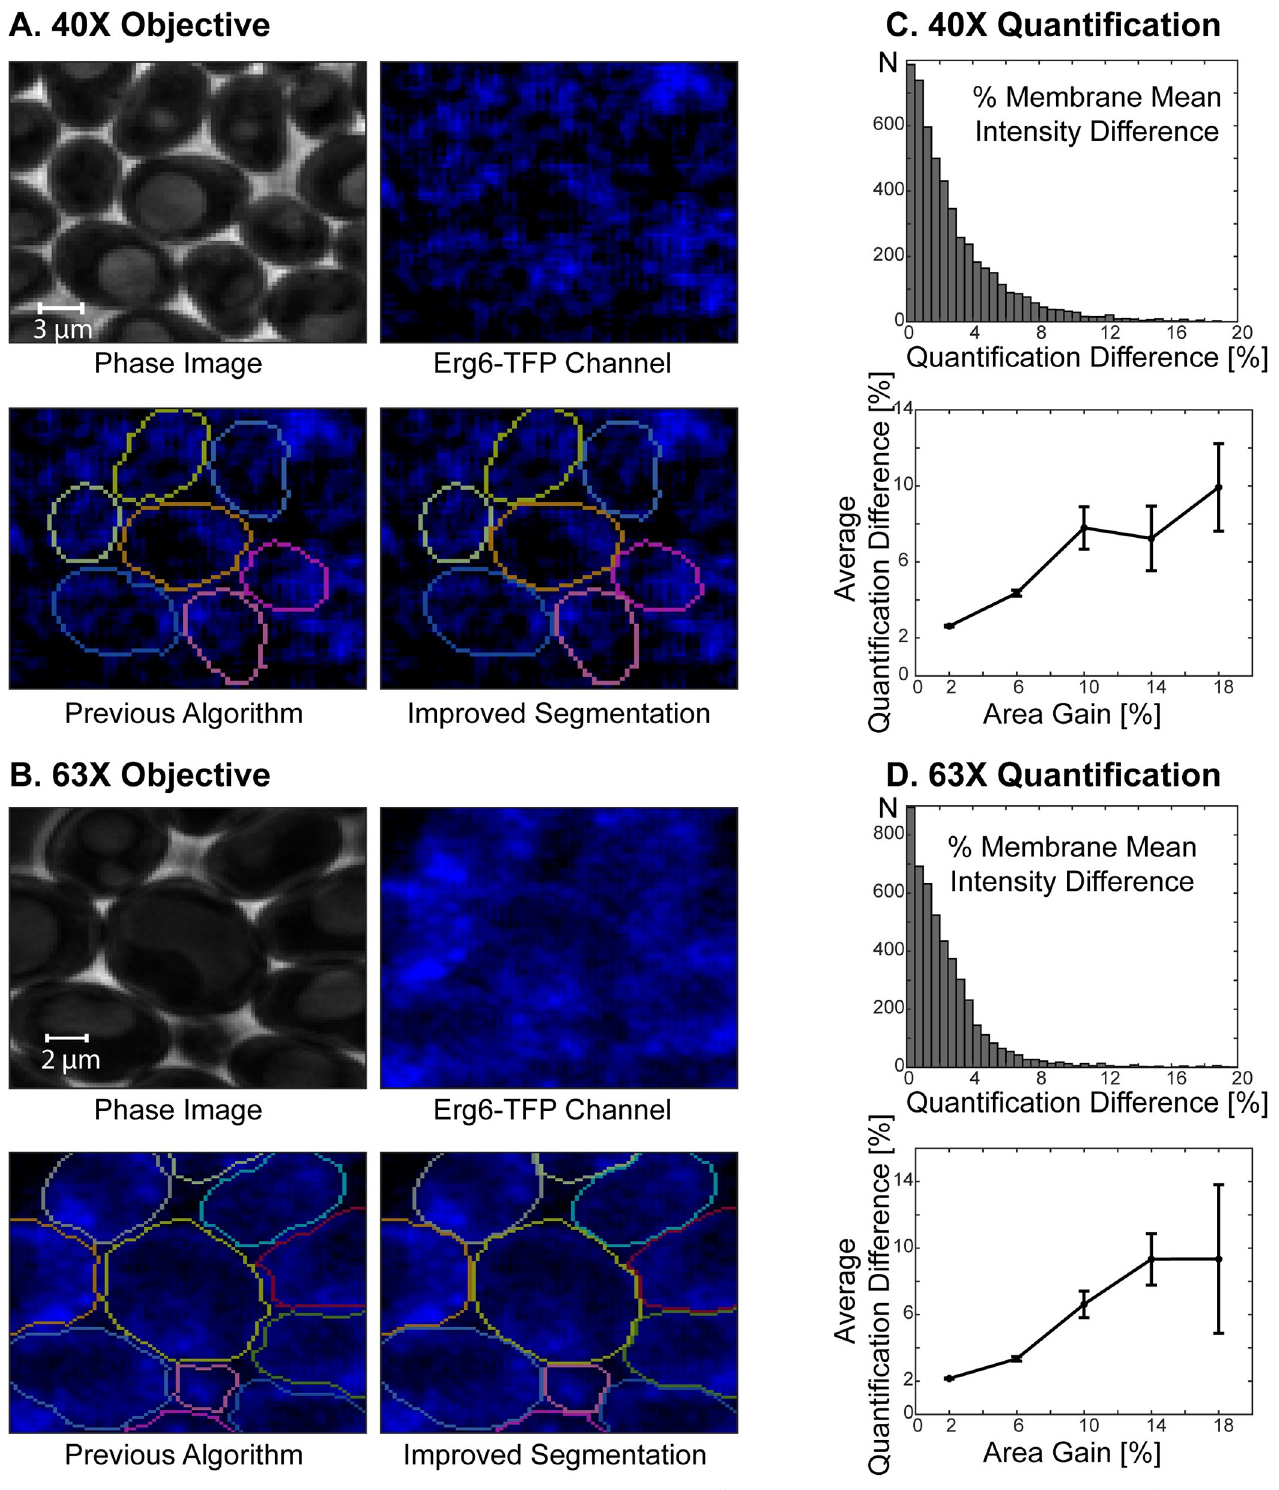
Fig 6. Quantification of the Erg6-TFP intensity at the cell periphery. (A-B) Example cells imaged with 40X (A) and 63X (B) objectives. The cell segmentations with the previous algorithm (without distributing the overlapping initial segmentations, but by removing them) and with the new algorithm (with distributing the overlapping initial segmentations) are shown side-by-side. Note that the cells are the same cells as shown in Fig 4. (C-D) Comparison of the Erg6-TFP mean intensity at the cell periphery with and without distribution the overlaps for 40X (C) and 63X (D) objectives. The same cells as in Fig 4 are